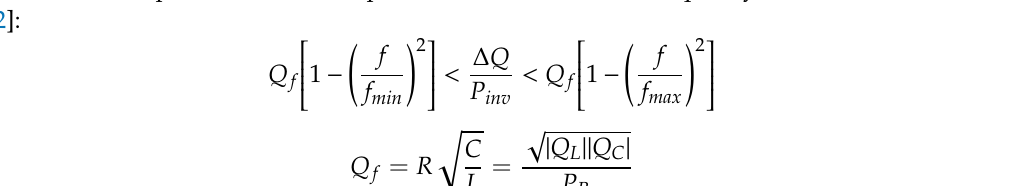
Figure 3. A simplified ride-through capability required in IEEE Std. 1547–2018: ( a ) voltage ride-through profile; ( b ) frequency ride-through profile (default setting). Table 1. Historical frequency trip settings of the distributed generation (DG) inverter.